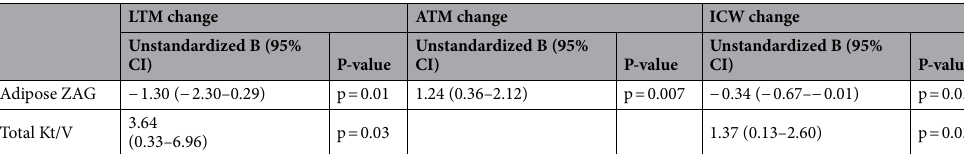
Table 4. Multivariate linear regression analysis on change in body composition. BMI body mass index, LTM lean tissue mass, ATM adipose tissue mass, ICW intracellular water, ZAG zinc alpha-2-glycoprotein, CI confidence interval. Co-variates included in the models: age, serum albumin, total Kt/V, malnutrition- inflammation score